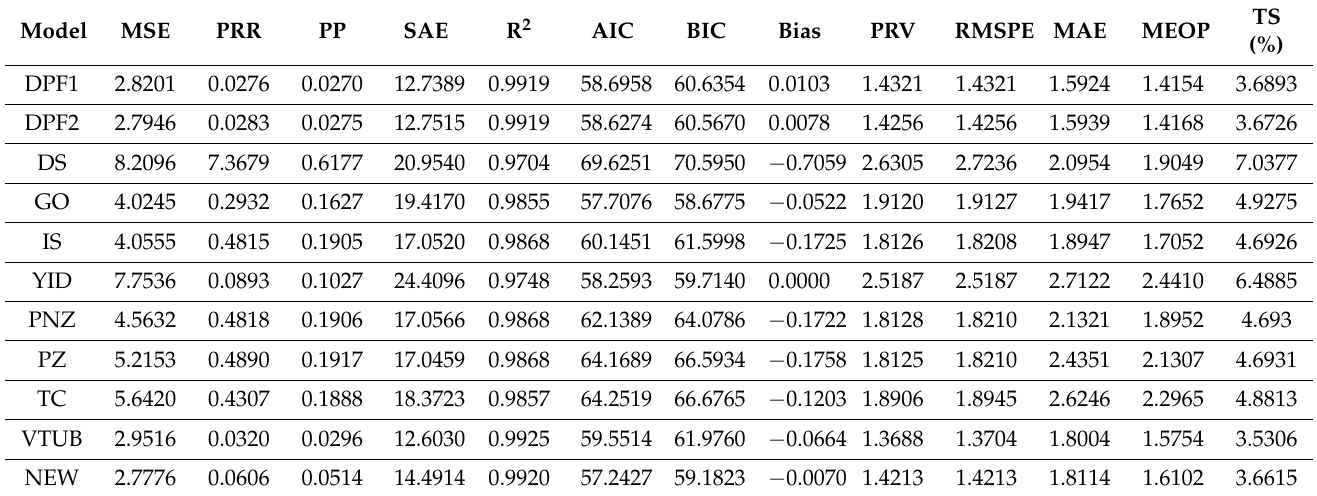
Table 8. Criteria values for model comparison of dataset